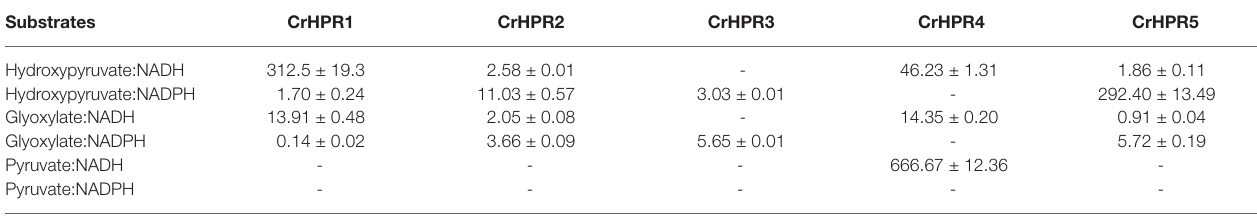
TABLE 1 | Activity assay of recombinant hydroxypyruvate reductases in Chlamydomonas (CrHPRs) with substrate and cofactor combinations. Substrates